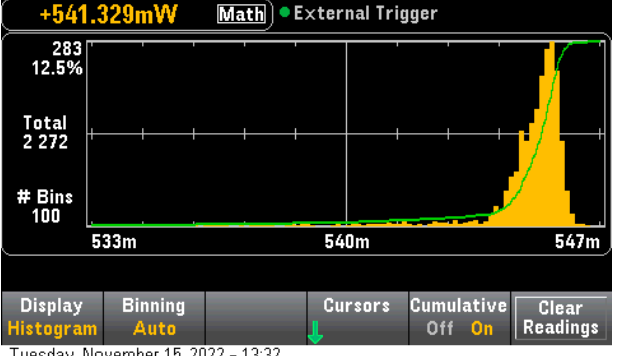
Figure 8. Quantized LeNet-5 Model Inference consumption on STM32H7.